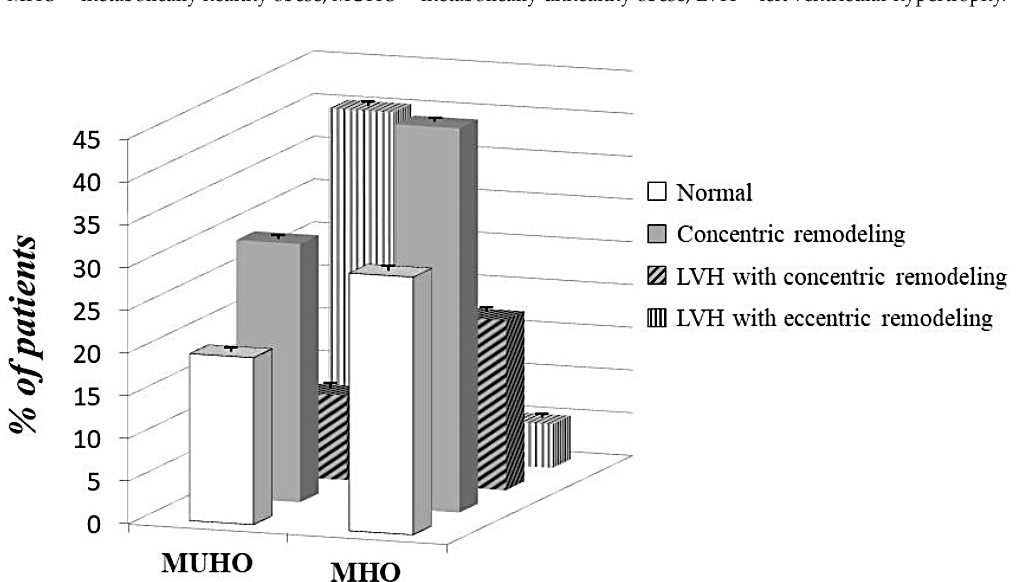
Table 4. Univariate and multivariate stepwise logistic regression analysis with left ventricular hypertrophy as dependent variable, in whole study population.